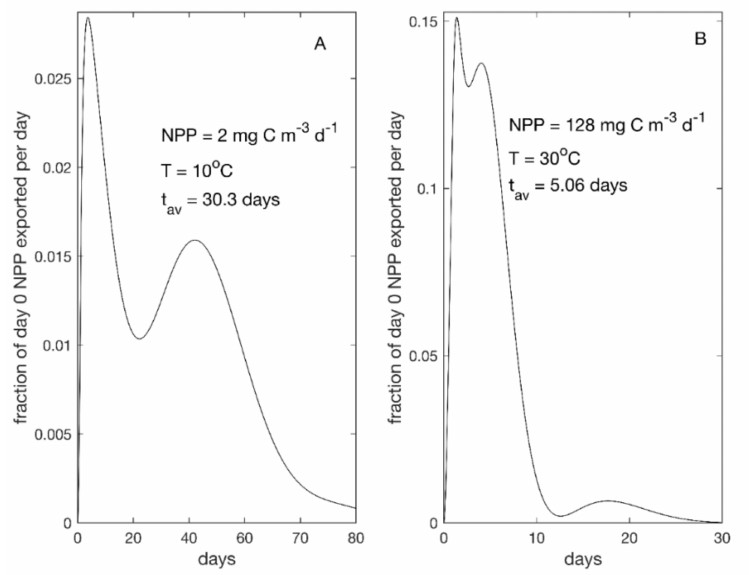
Figure 5. ( A ) Time course of fractional export of new production on day zero based on the steady state food web model at 10 ◦ C and an NPP of 2 mg C m − 2 d − 1 and ( B ) 30 ◦ C and an NPP of 128 mg C m − 2 d − 1 .